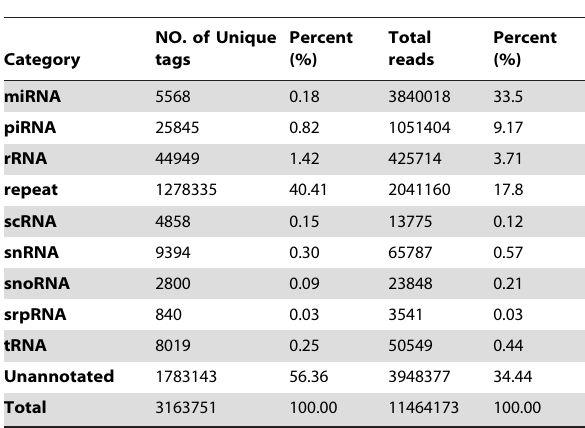
Table 1. The match results of clean